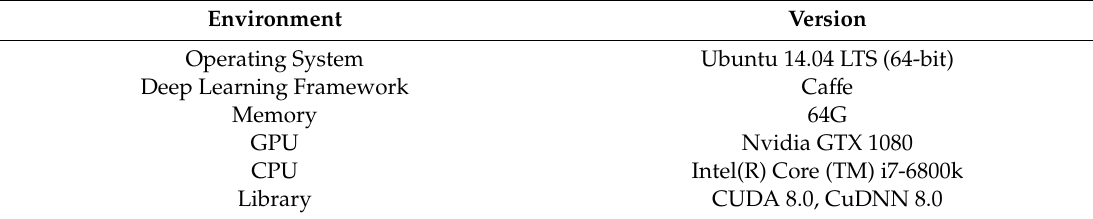
Table 5. Experimental environment configuration.